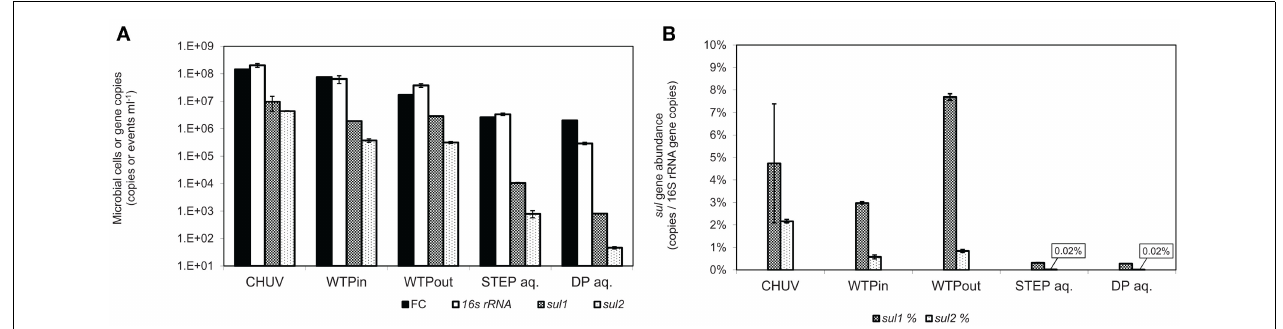
FIGURE 3 | (A) Total gene copy numbers and flow-cytometric cell counts, normalized to sample volume. (B) Relative abundance of sulfonamide resistance gene copy numbers normalized to 16S rRNA gene copies. Error bars indicate standard deviation from triplicate real-time PCR amplification of the same sample.